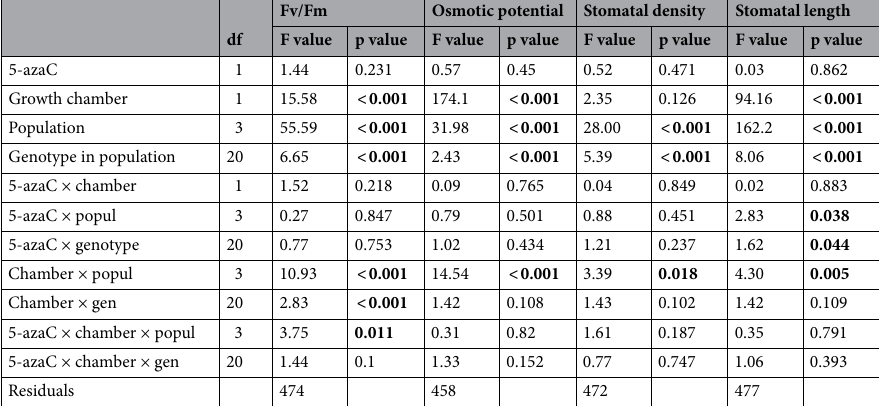
Table 1. The effect of 5-azaC application, growth chamber, population of origin and genotype and their interactions on F v /F m , osmotic potential, stomatal density and stomatal length in the growth chambers. Genotype was nested in population of origin. Significant values (p ≤ 0.05) are in bold.